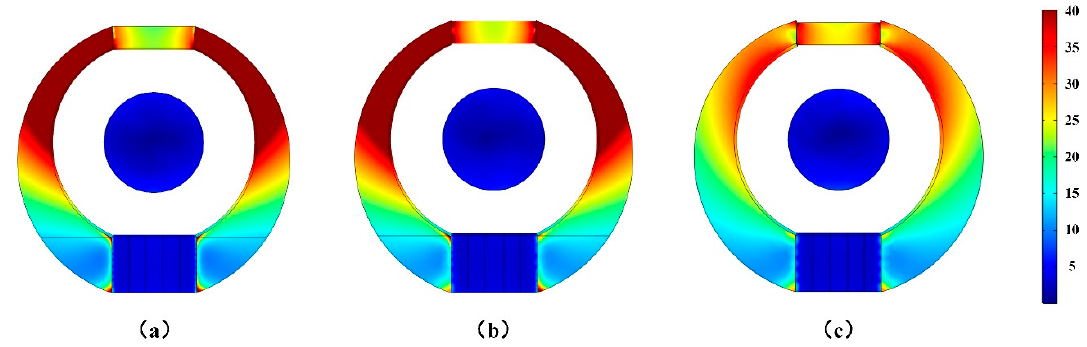
Figure 2. The magnetic flux density distribution of sensors with different structures at a current of 400 A. ( a ) sensor based on the cuboid magnetostrictive material. ( b ) sensor based on the cylindrical magnetostrictive material. ( c ) sensor based on the semi-cylindrical magnetostrictive material.